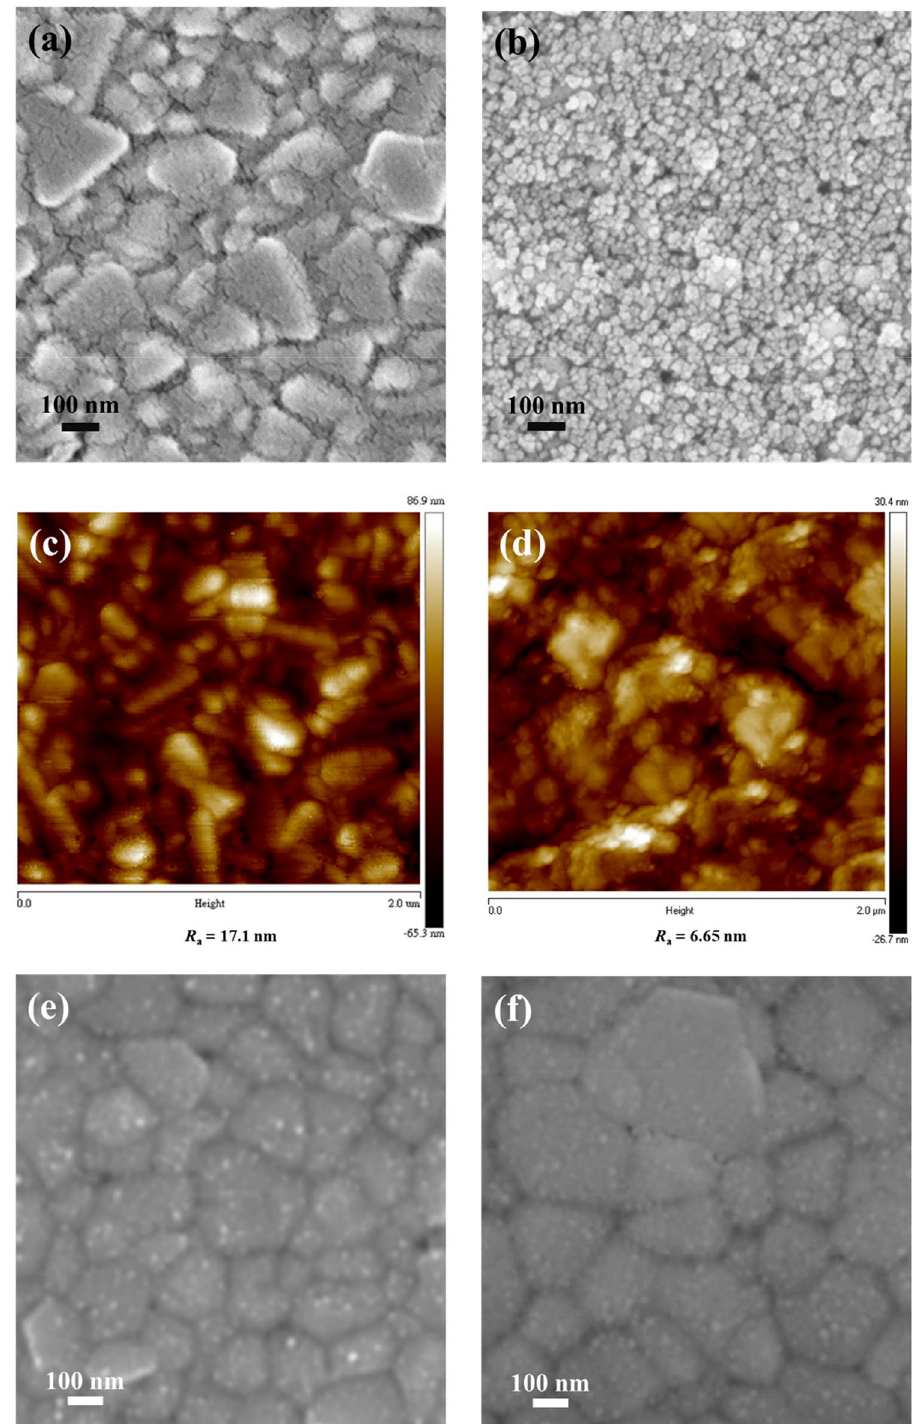
Figure 5. Top-view SEM and AFM topographic images of ( a ) ( c ) PEDOT:PSS film and ( b ) ( d ) ZnCo 2 O 4 NPs layer deposited on FTO substrates. Top-view SEM images of the perovskite deposited on ( e ) PEDOT:PSS film and ( f ) ZnCo 2 O 4 NPs